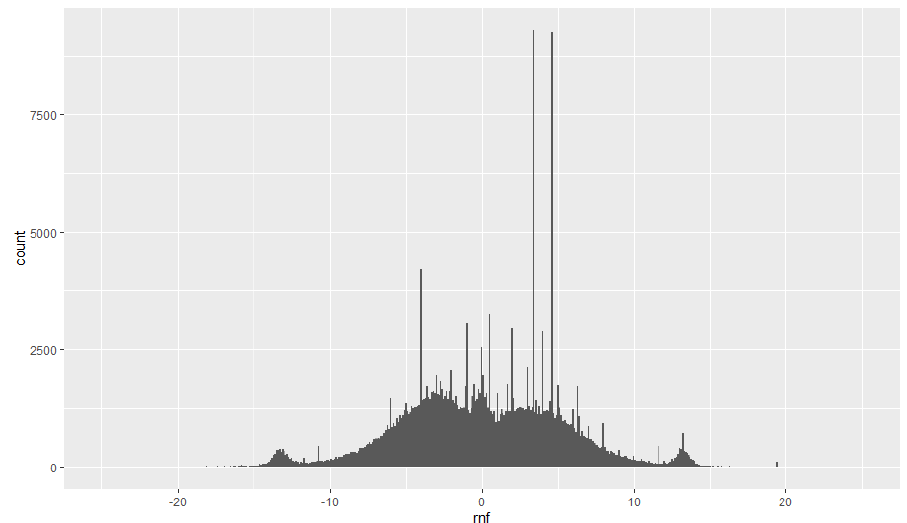
Figure 9. A histogram of differences in motor loads. Source: Own study.